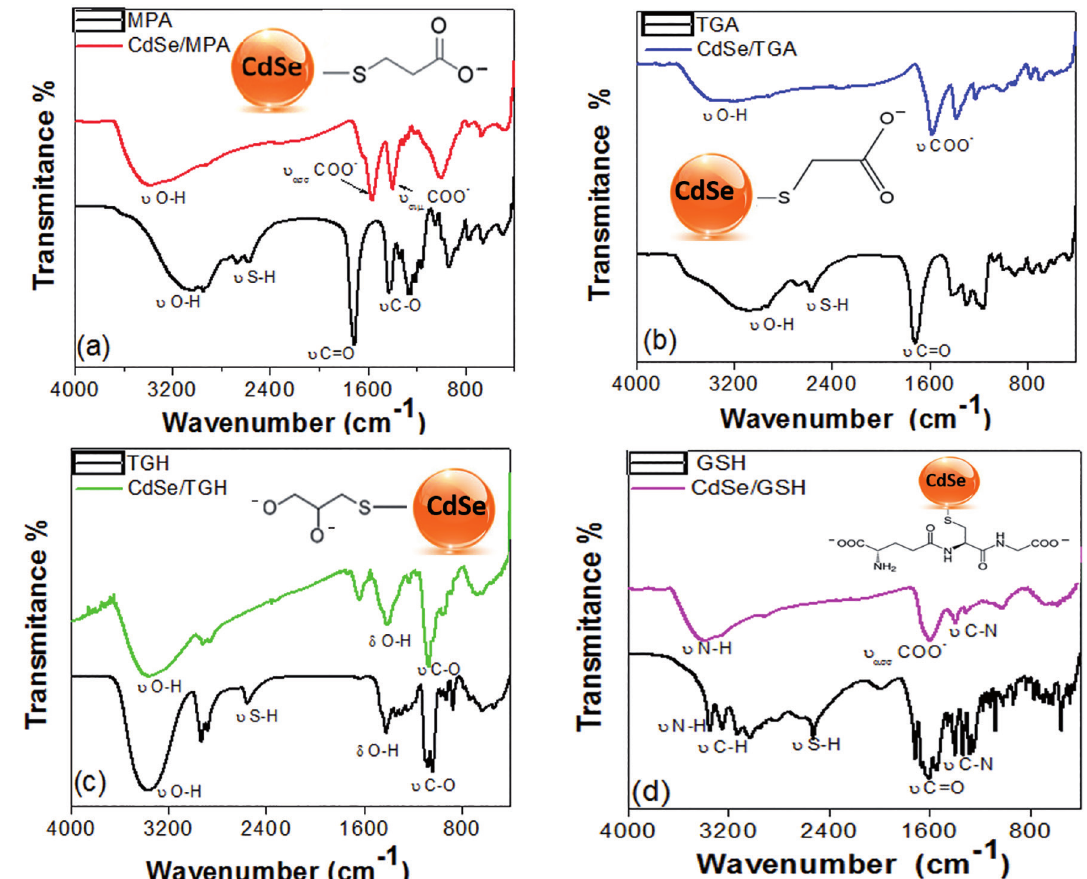
Figure 8: Infrared spectra of CdSe QDs capped with (a) MPA, (b) TGA, (c) TGH, and (d) GSH. Table 1: Position of the maximum fluorescence in relation to the diameter of MPA-capped CdSe QDs. Maximum fluorescence position